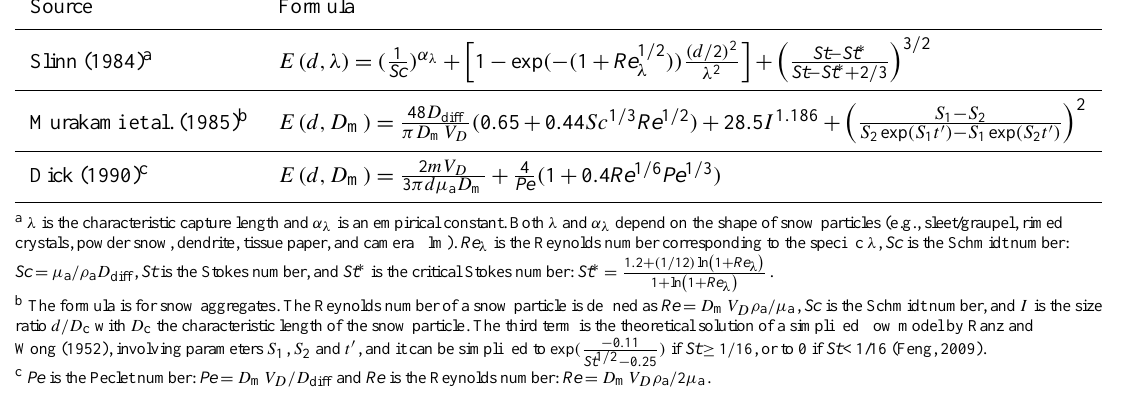
Table 5. List of exponential snow particle number size distribution ( N(D p )) formulas. Note that actual snow particle size D m (cm) was used in Scott (1982) (see Appendix A in Zhang et al., 2013), whereas D p was used in other